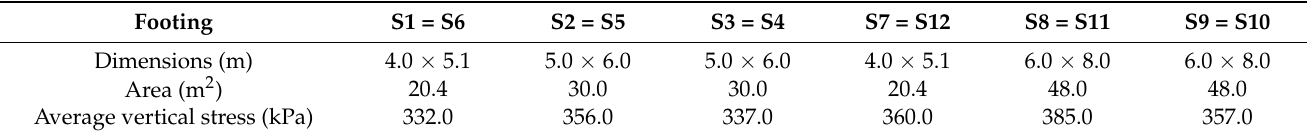
Table 1. Vertical normal stresses applied for each footing.